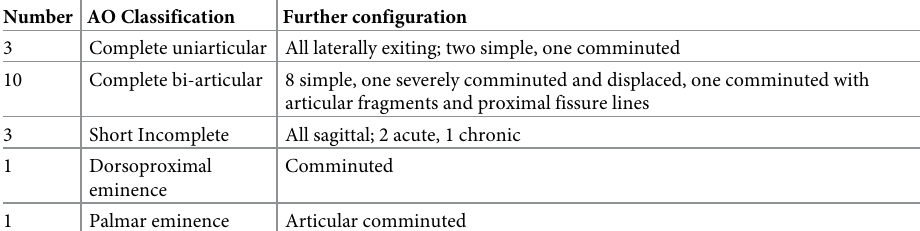
Table 1. Proximal phalanx